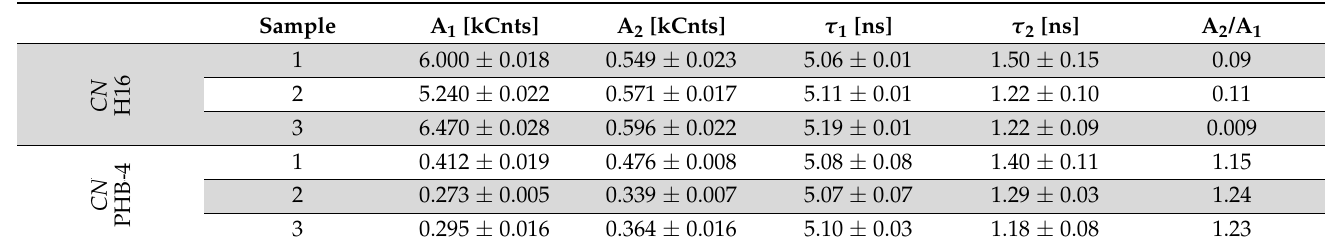
Table 2. Fluorescence intensity, A [kCnts]; average fluorescence lifetimes, τ 1 and τ 2 , for samples dyes with BODIPY